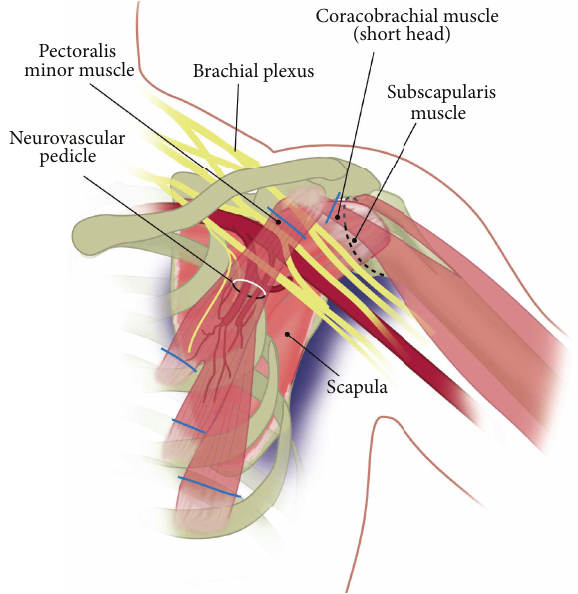
Figure 1: Picture of pectoralis minor origin and insertion and its relation to axillary artery and brachial plexus and penetration point of